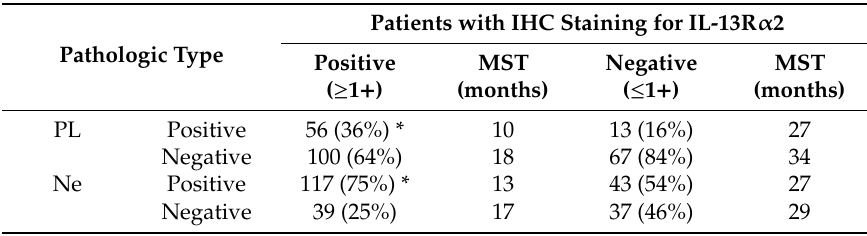
Table 3. Analysis of IL-13R α 2 in perineural invasion in